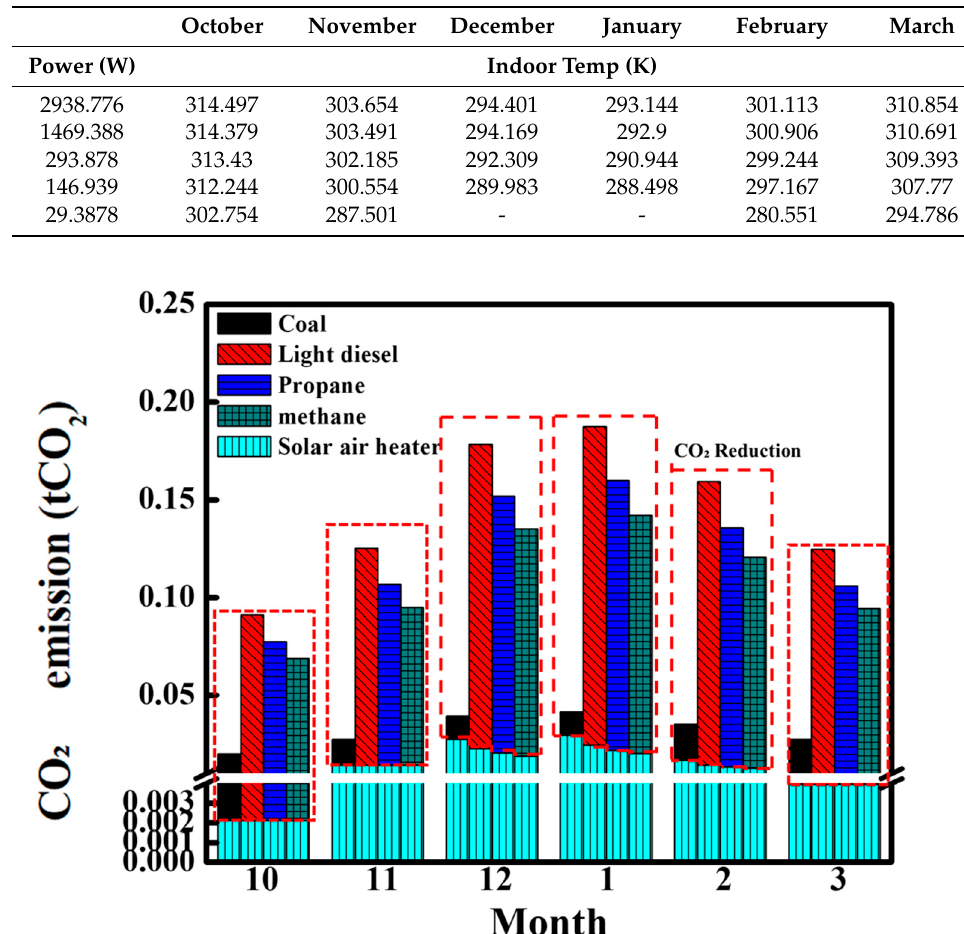
Figure 10. CO 2 generated from a conventional heater by consuming four different fossil fuels. CO 2 reduction achieved with a solar air heater was marked with a red dotted box.